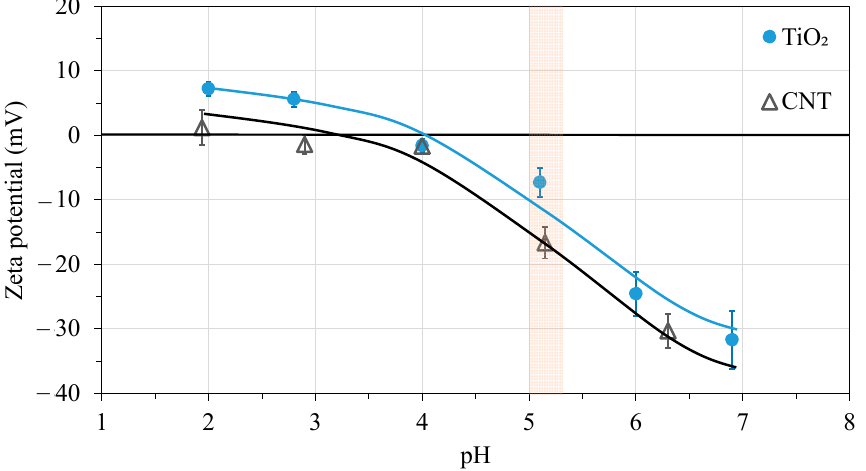
Figure 3. Zeta potentials of CNT and TiO 2 coatings (the pH of the oil emulsion was 5.2 ± 0.15).